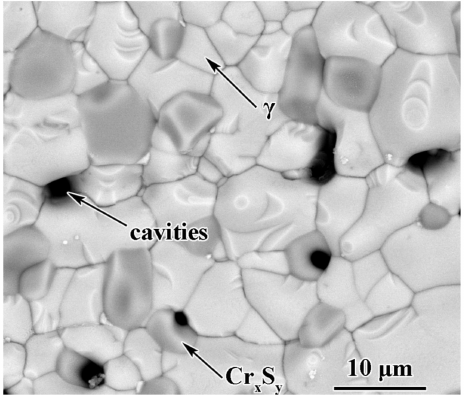
Figure 11. Image of the bare internal sulfidation zone (D zone in Figure 8).